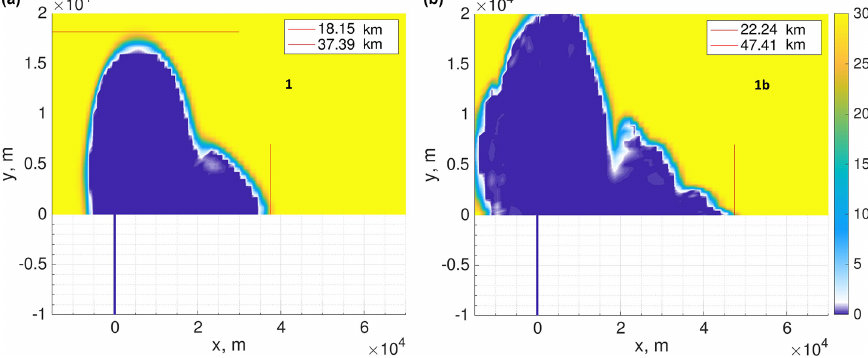
Figure A1. The surface salinity, in practical scale, at 35h as a result of runs 1 (a) and 1b (b) (see Table A1 for the run